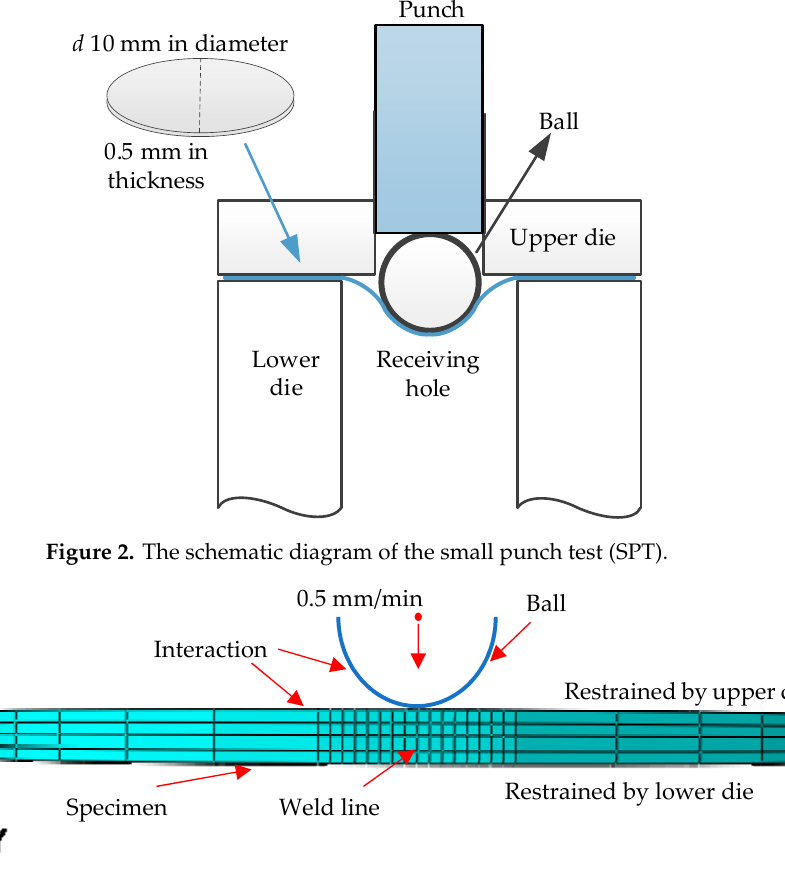
Figure 3. The finite element model of the small punch specimen.